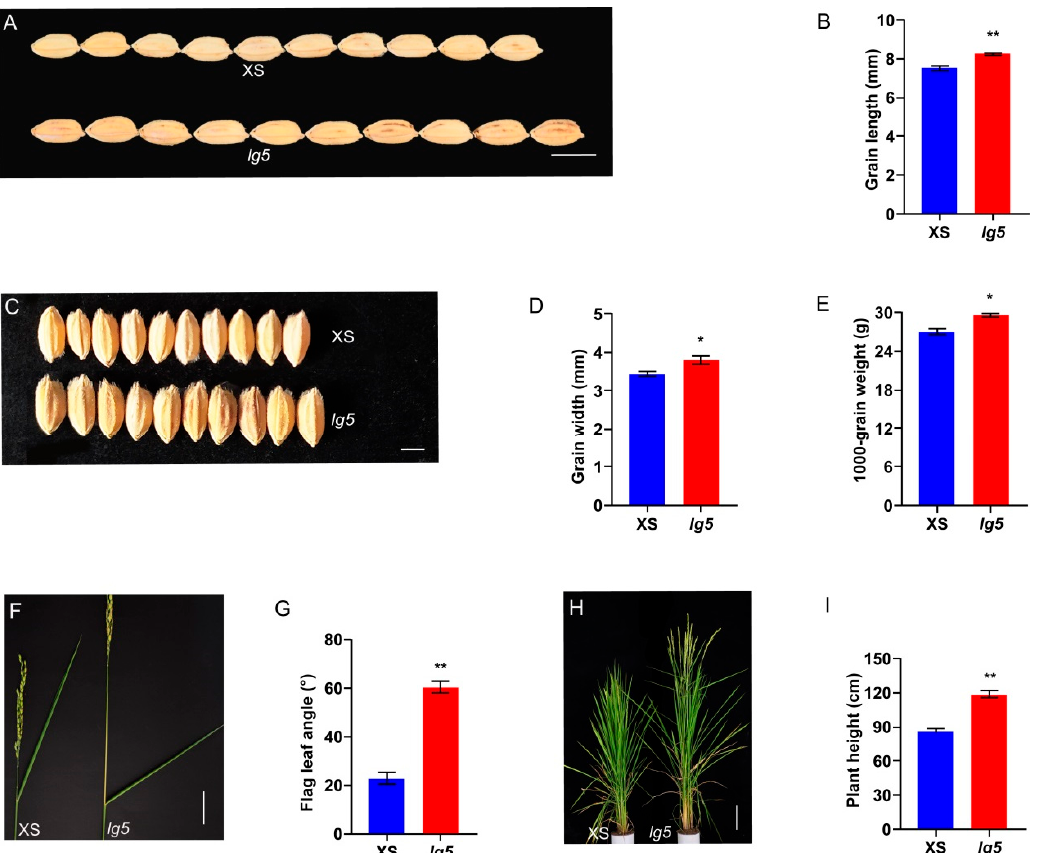
Figure 1. Comparison of agronomic traits between XS and lg5 in the mature stage. ( A , B ) Grain length of XS and lg5 ; bar = 8 mm. ( C , D ) Grain width of XS and lg5 ; bar = 3.5 mm. ( E ) Thousand-grain weight of XS and lg5 . ( F , G ) Flag leaf angle of XS and lg5 ; bar = 5 cm. ( H , I ) Plant height of XS and lg5 ; bar = 15 cm. Data are presented as means ± SD. * and ** indicate p < 0.05 and p < 0.01, respectively, according to Student’s t -test.